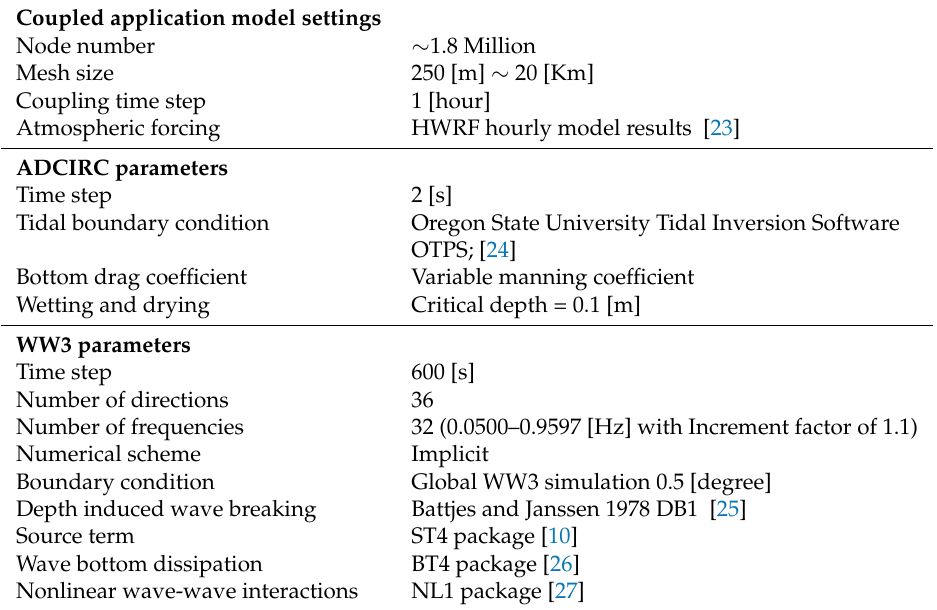
Table 4. Numerical model set-up and boundary